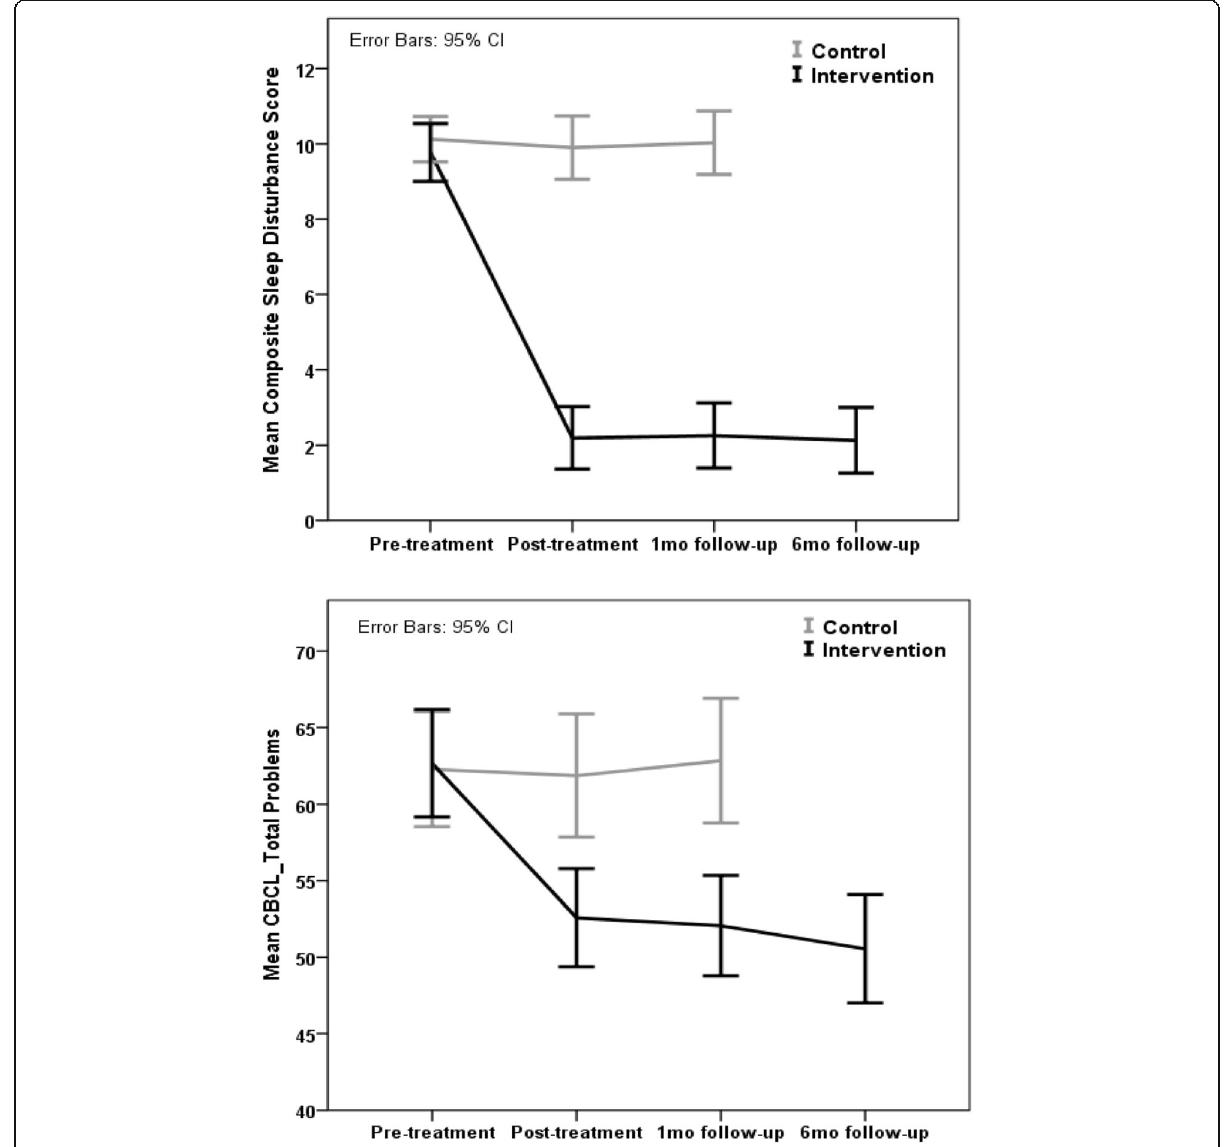
Fig. 2 Difference between the groups in terms of the CSDS scores and total